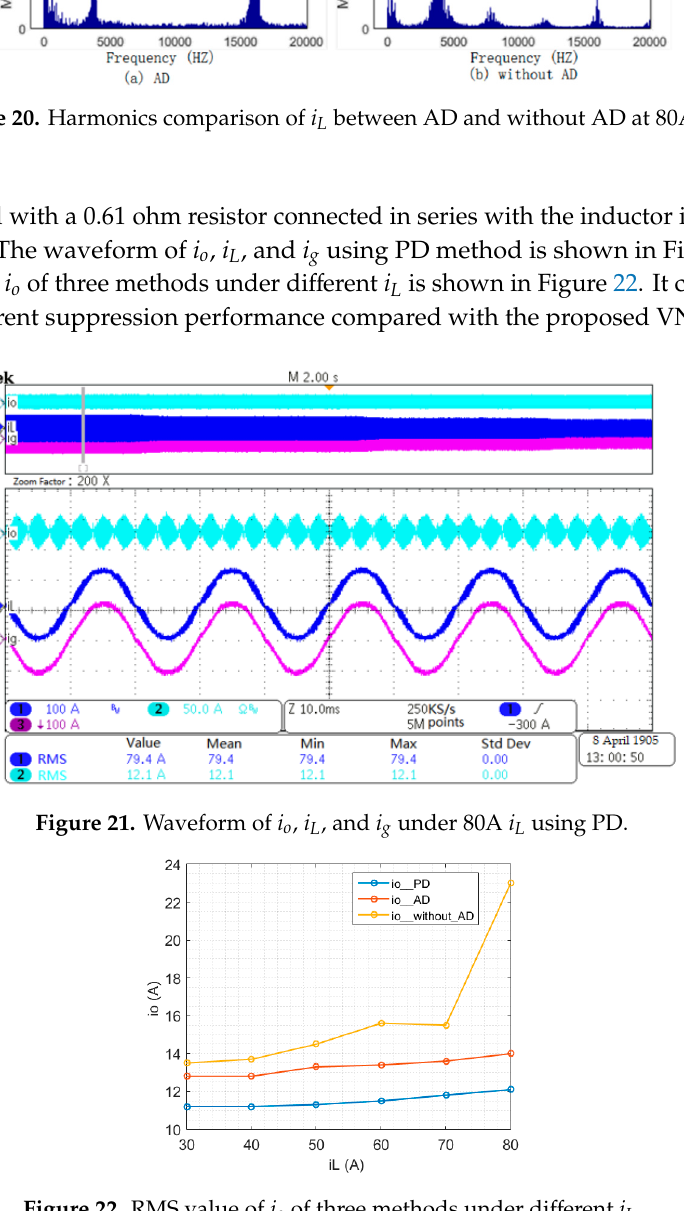
Figure 20. Harmonics comparison of i L between AD and without AD at 80A i L .